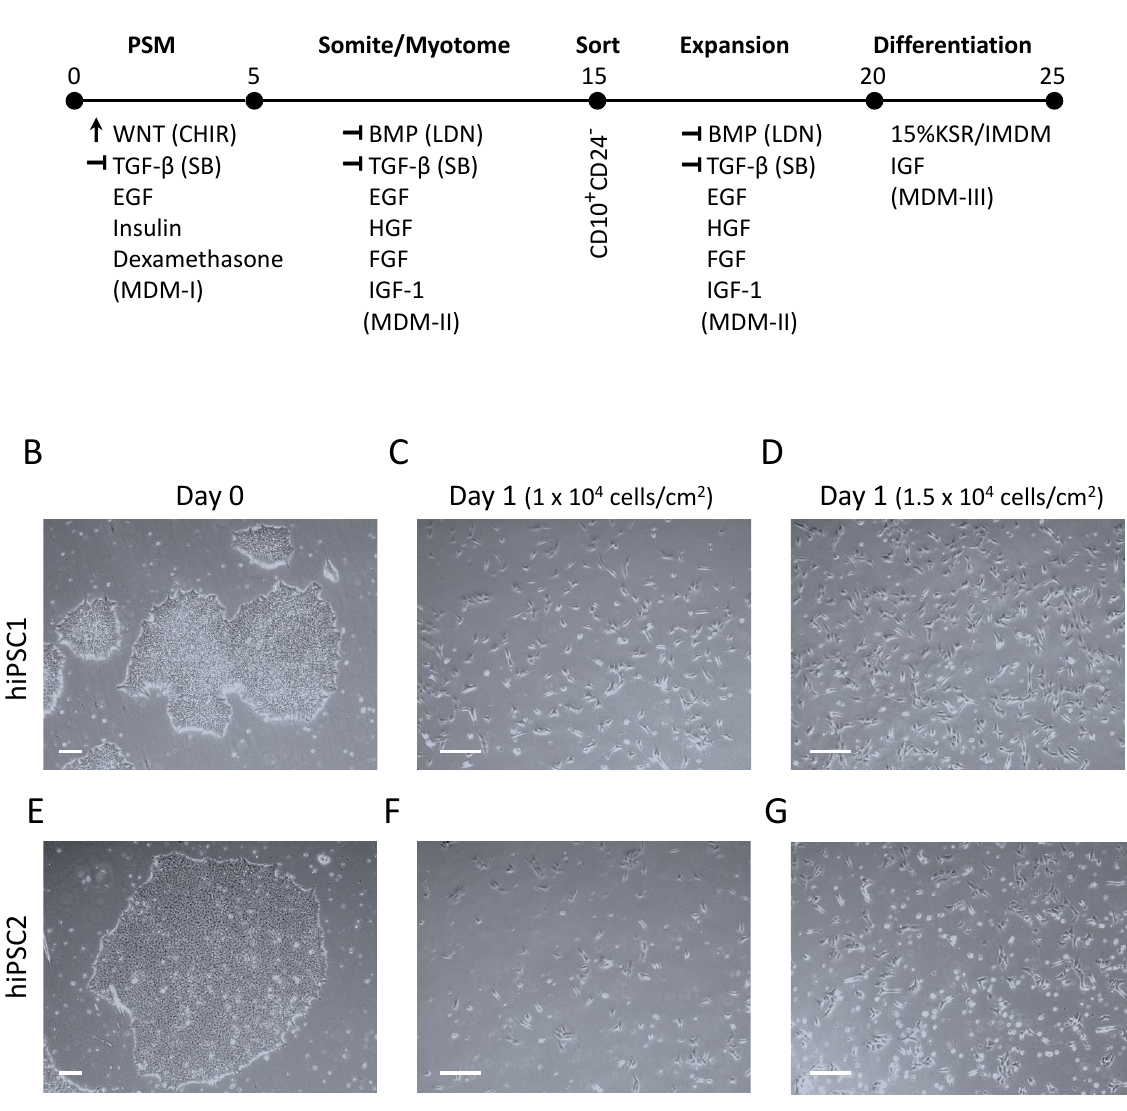
Figure 1. Protocol timeline and the effect of initial cell plating density on cell survival at Day 1 of differentiation. ( A ) Schematic figure demonstrating important stages of differentiation protocol. Important signaling molecules and growth factors for each stage of differentiation are listed. ( B – G ) Demonstration of the effect of initial cell density on cell survival after 1 day of differentiation. Upper row (iPSC1, B – D ) demonstrates a control human iPSC line with acceptable cell survival at both tested densities. Lower row (iPSC2, E – G ) indicates another iPSC line with reduced cell survival at 1 × 10 4 cells/cm 2 ( F ). Increasing initial plating density to 1.5 × 10 4 cells/cm 2 improved cell survival at Day 1 ( G ). Scale bars: 100 µm.